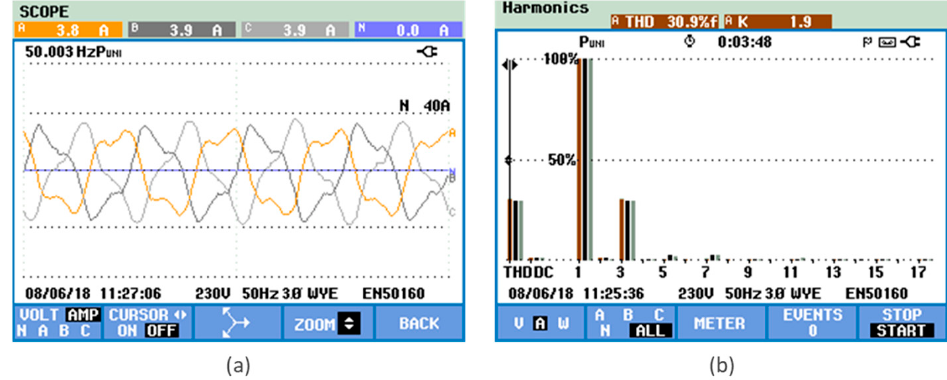
Figure 12. Experimental validation showing a result that validates the operation of the unified topology injecting third order harmonic currents ( i UTa , i UTb , i UTc ), to compensate these harmonic currents in the power grid: ( a ) current waveforms; ( b ) harmonic spectrum.